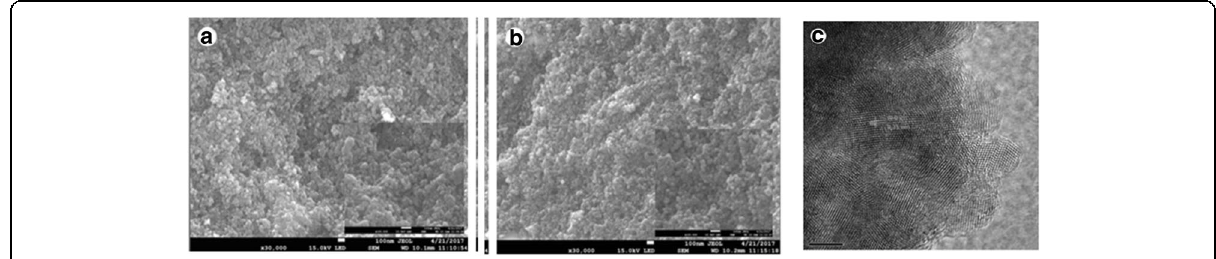
Fig. 26 SEM images of a CdS/CdSe and b CdS/Mn:CdSe QD sensitization on TiO 2 surface. c TEM image of CdS/Mn:CdSe QDs